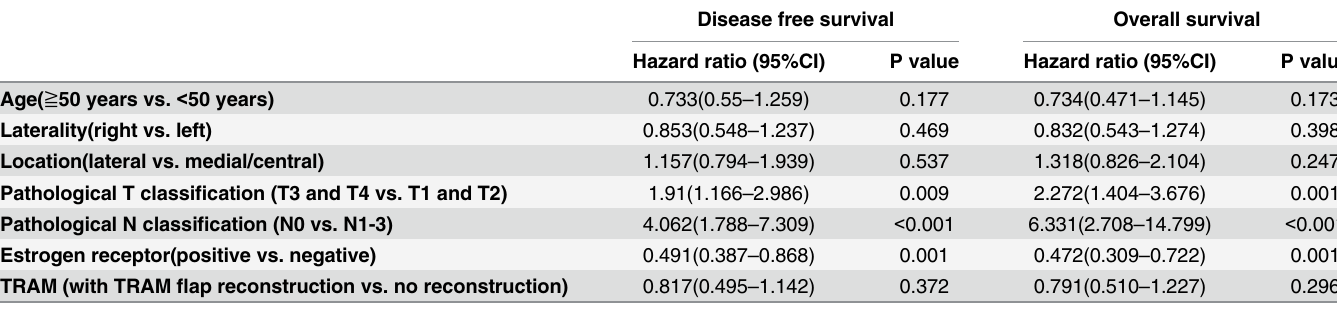
Table 3. Multivariate analyses of 492 breast cancer patients by Cox ’ s disease free survival and overall survival.